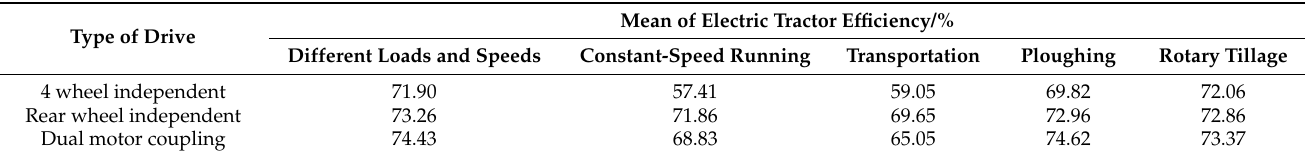
Table 8. Estimation results of mean of full vehicle efficiency of three drive systems for electric